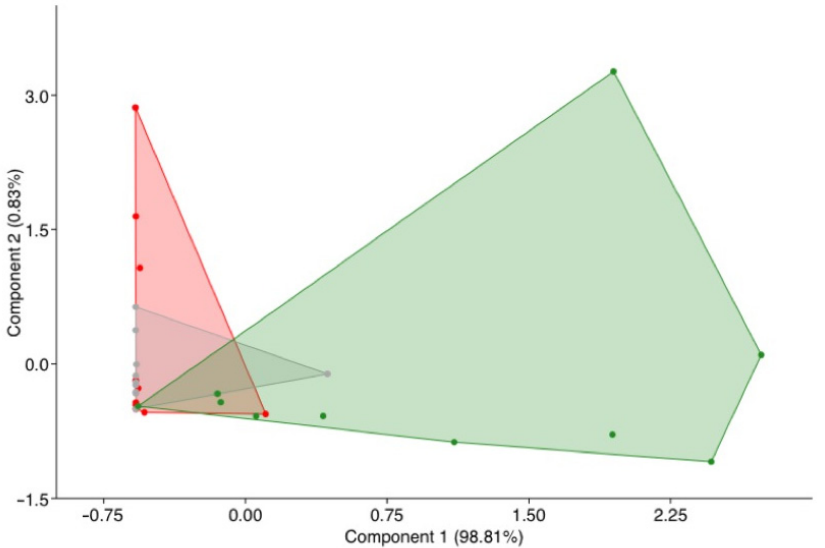
Figure 3. Principal component analysis. Red dots: traditional system, grey dots: conventional system, green dots: agroecological system. Variables used in the analysis are those listed in Table 1.